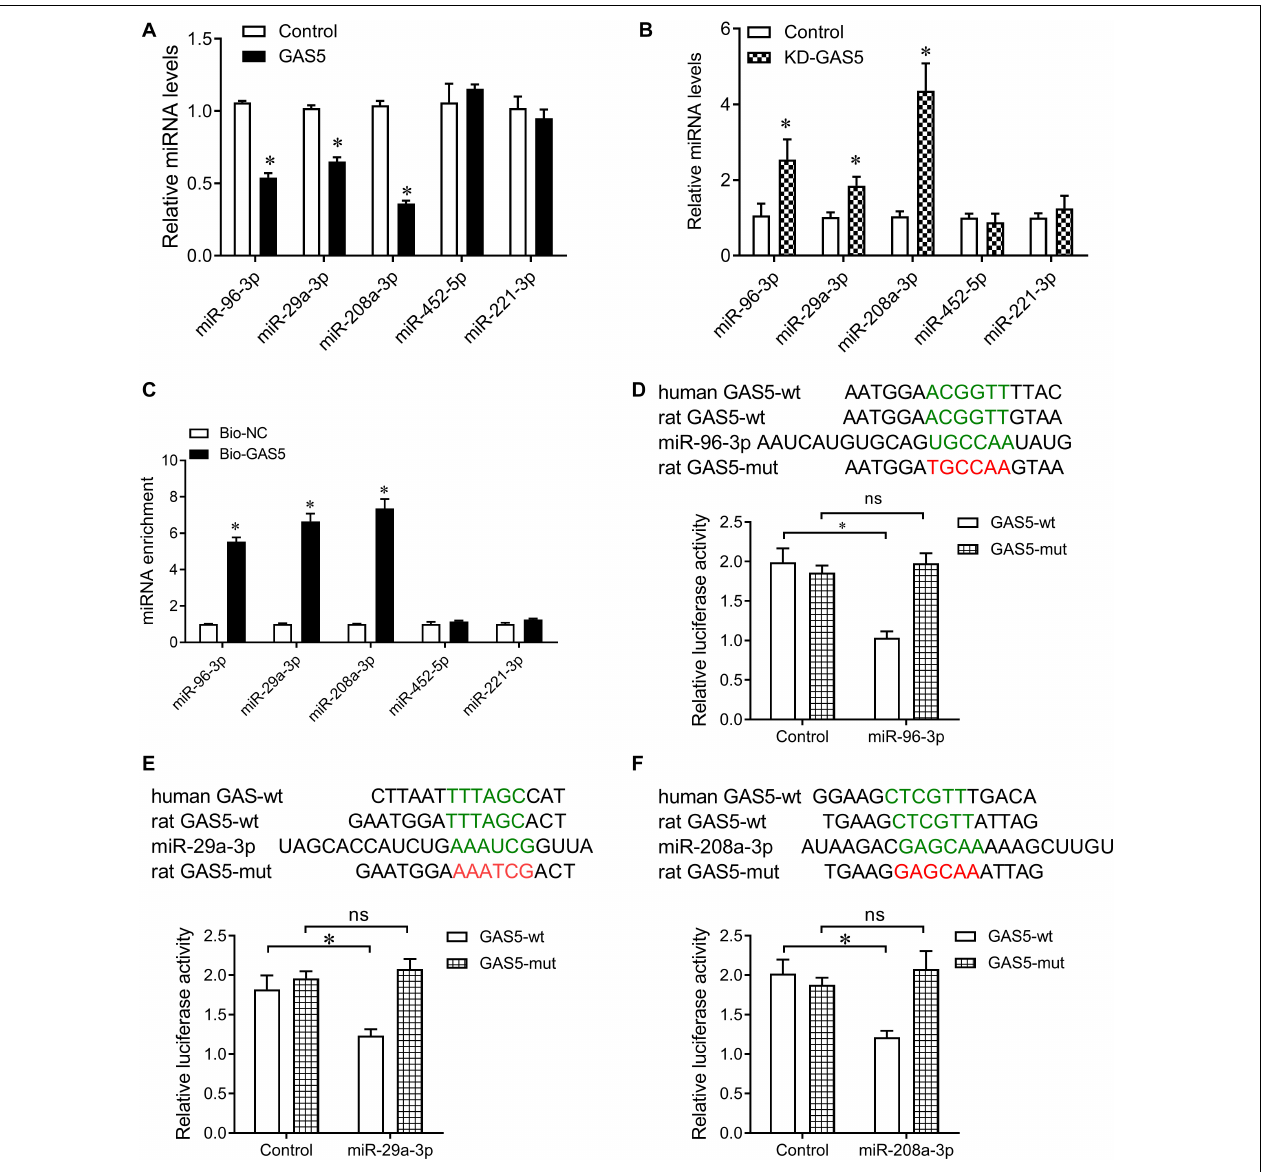
FIGURE 4 | GAS5 negatively regulates the expression of miR-29a-3p, miR-96-3p, and miR-208a-3p. (A) QPCR was performed to determine the expression of miR-29a-3p, miR-96-3p, miR-208a-3p, miR-452-5p, and miR-221-3p in INS-1 832/13 cells after transfection with lentivirus carrying GAS5 DNA sequence or empty pReceiver-Lv218 vector control. (B) QPCR was performed to determine the expression of miR-29a-3p, miR-96-3p, miR-208a-3p, miR-452-5p, and miR-221-3p in INS-1 832/13 cells after transfection with lentivirus carrying GAS5 shRNA sequence or scramble control. (C) Pull-down assay with biotinylated GAS5 probe (Bio-GAS5) was performed to determine the interaction of GAS5 with miR-29a-3p, miR-96-3p, and miR-208a-3p in INS-1 832/13 cells. MiR-29a-3p, miR-96-3p, and miR-208a-3p were significantly enriched in the complex pulled down by Bio-GAS5 compared with Bio-NC. (D–F) The wild type binding sites of GAS5 and miRNAs (indicated by green), and the mutant type (indicated by red) were shown (upper). Dual luciferase reporter gene assay was performed to validate the interaction between GAS5 and miR-29a-3p, miR-96-3p, and miR-208a-3p (lower). Data were presented as mean ± SD. * p < 0.05 vs. control. KD, knockdown; ns, no